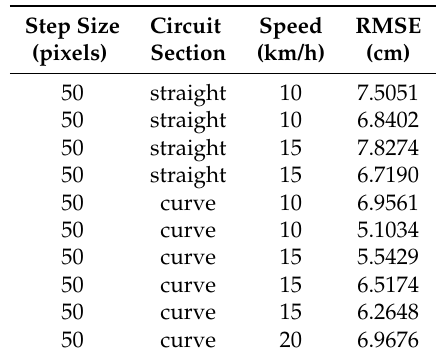
Table 1. Evaluation of the system behavior against step disturbances of 50 pixels at different speeds and location inside the